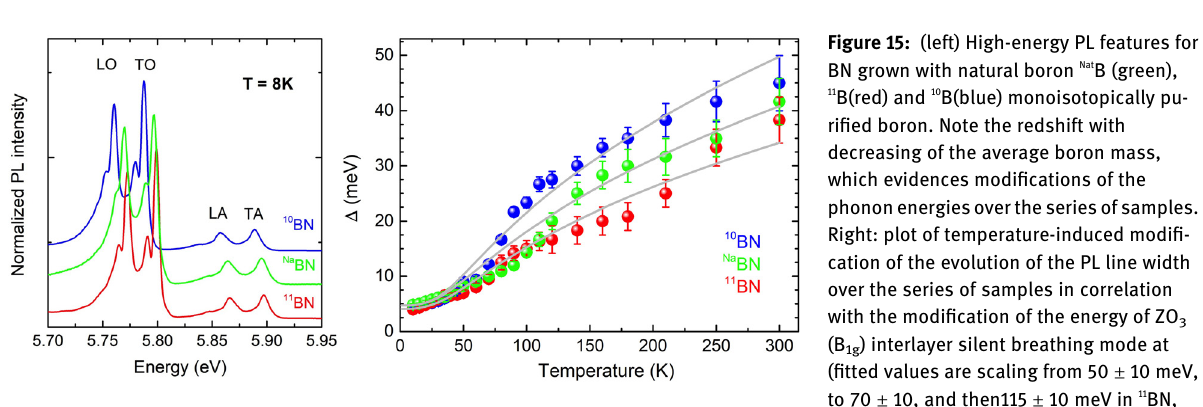
Figure 14: (left) sketch of the scattering mechanism for electronic raman scattering giving birth to the overtoning via the low frequencyramanactivemodeE 2g . (right)Full line shape fi tting using gaussian functions broadened proportionnaly to the phonon group velocity at the middle of the Brillouin zone.